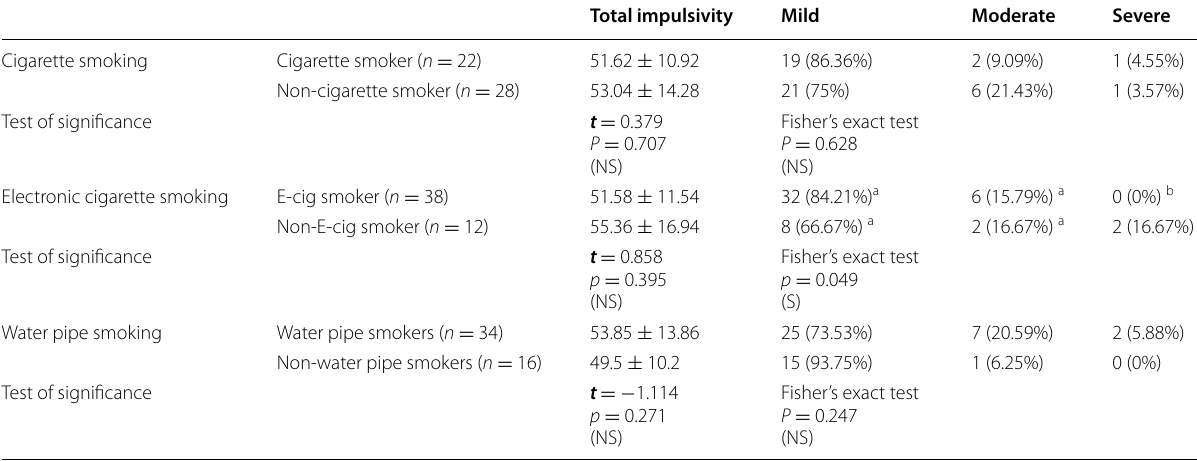
t , Student t -test of significance; Sig. , significant; S , significant; NS , non-significant; E-cig , electronic cigarette Each subscript letter denotes a subset of group categories whose column proportions do not differ significantly from each other at the .05